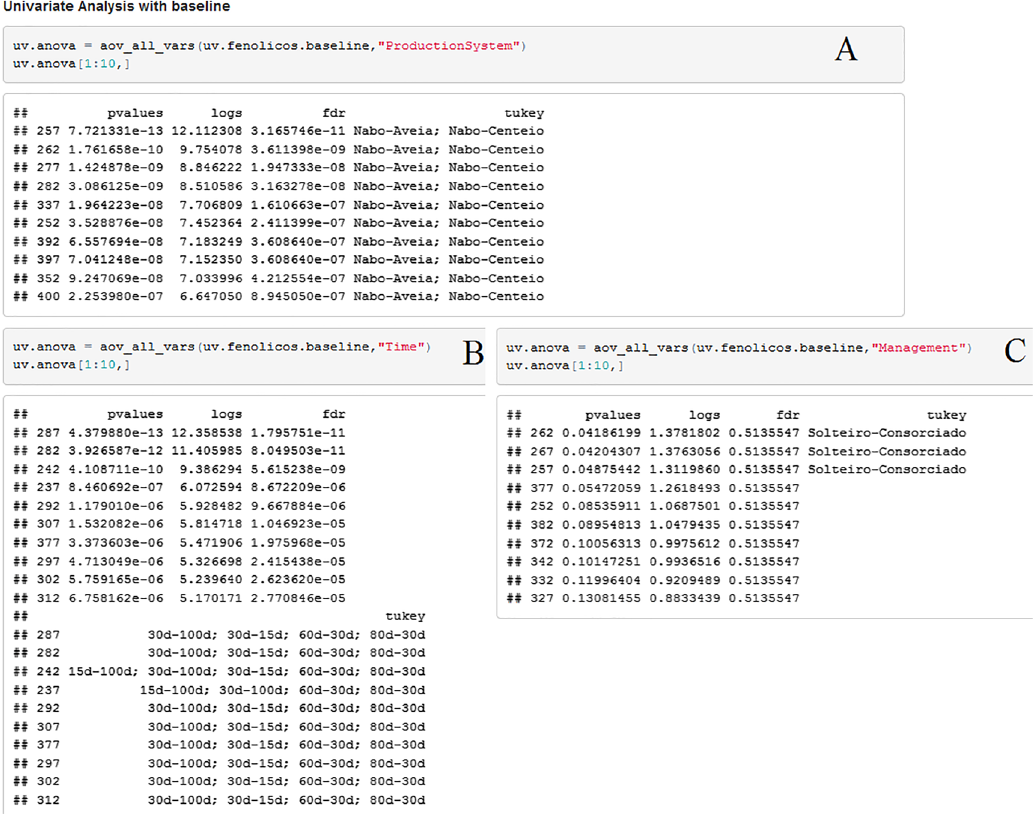
Figure 6: Univariate analysis performed on the UV–vis spectra and the wavelengths that contributed the most for the clustering according to plant species (A), period of sampling (B) and crop management system